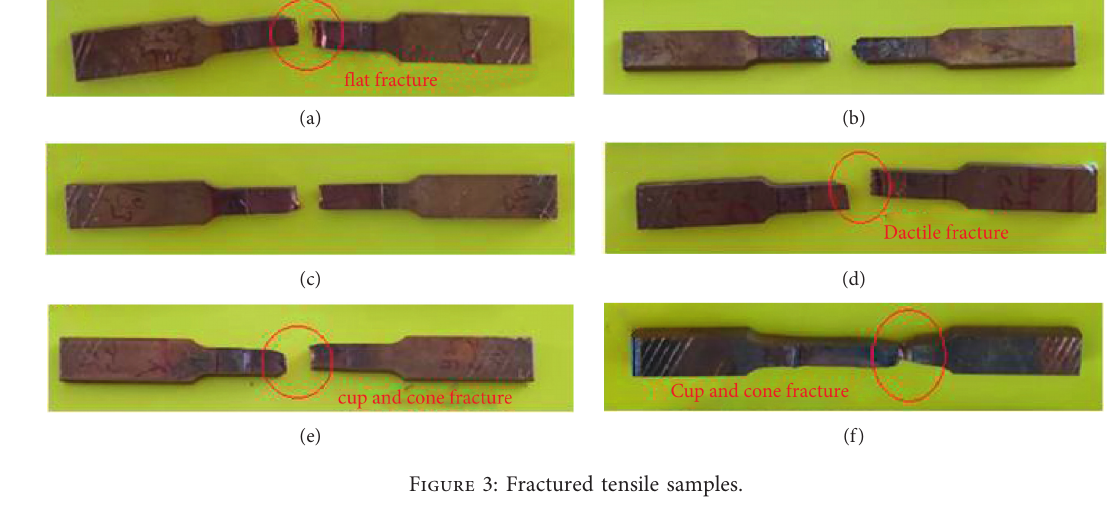
Figure 3: Fractured tensile samples.